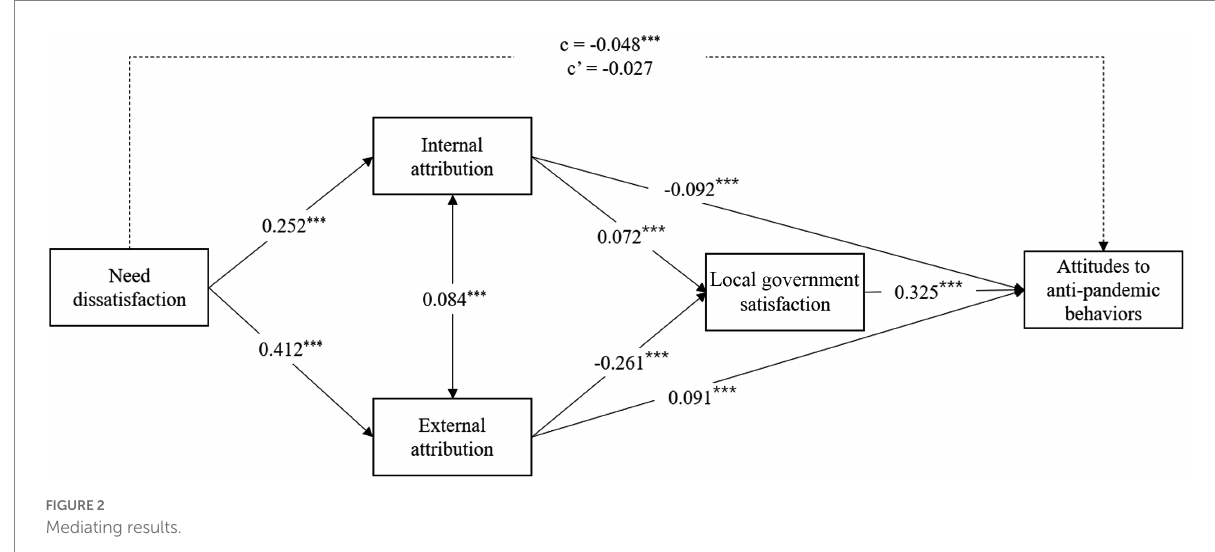
FIGURE 2 Mediating